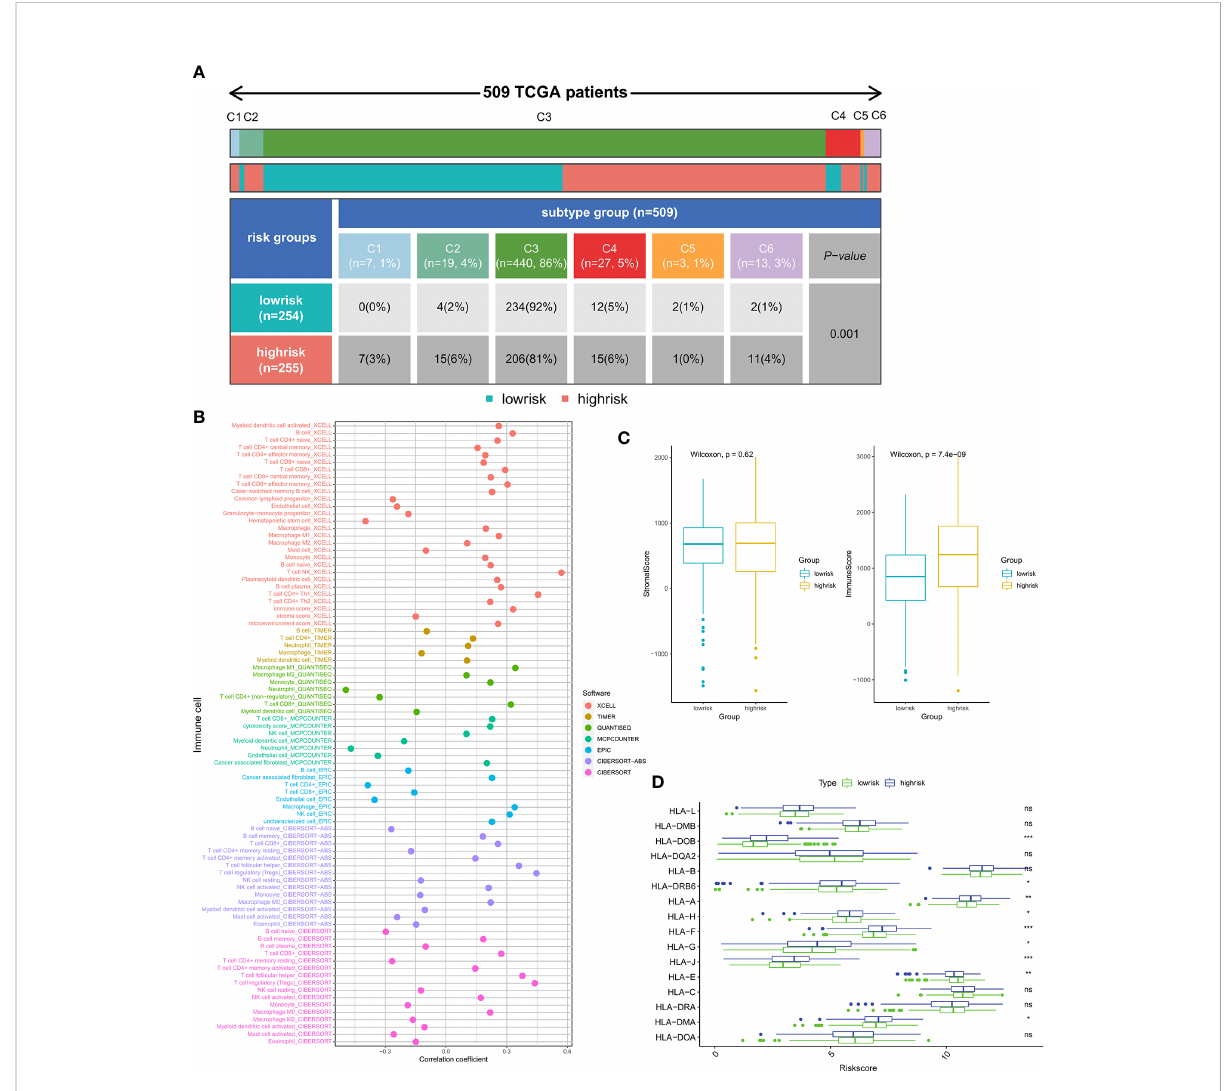
FIGURE 6 Relationship between immune in fi ltration and riskscore: (A) The proportion of patients with different immune subtypes between the high- and low-risk groups. (B) The correlation of the riskscore and immune cell in fi ltration levels. (C) Comparison of Immune score and Stromal score between the high- and low-risk subgroups. (D) The expression of the HLA gene family between the high- and low-risk groups. (*p < 0.05, **p < 0.01, ***p < 0.001). ns, no signi fi